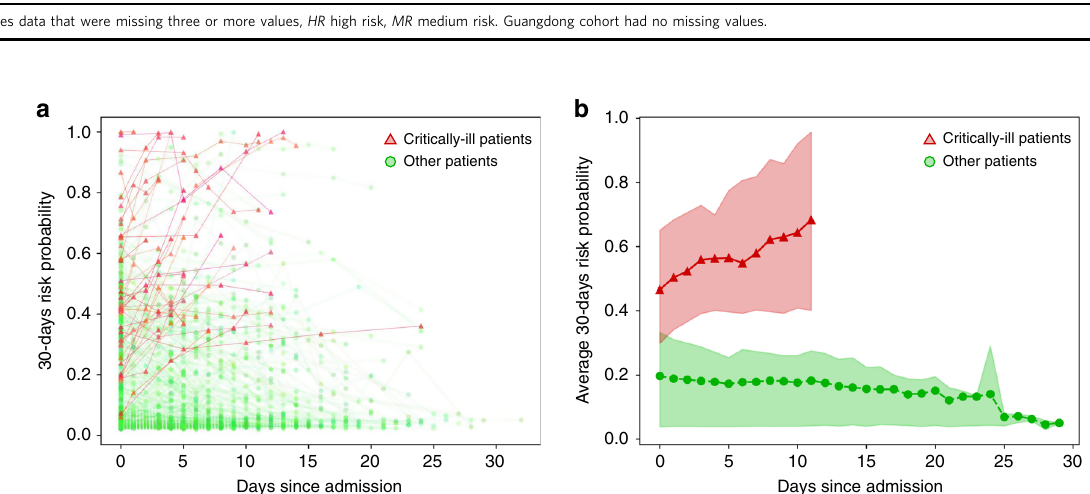
Table 2 Results of Deep Learning Survival Cox analyses on the three independent external validation cohorts. Cohort No. of patients (critically)